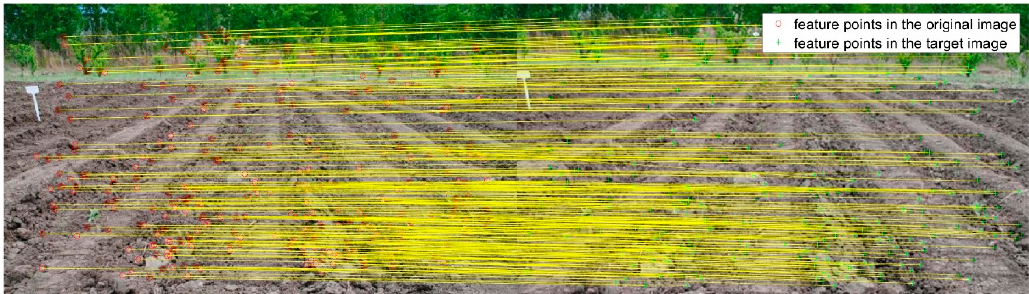
Figure 5. The registration result of MSER − M for target image in Figure 2b.